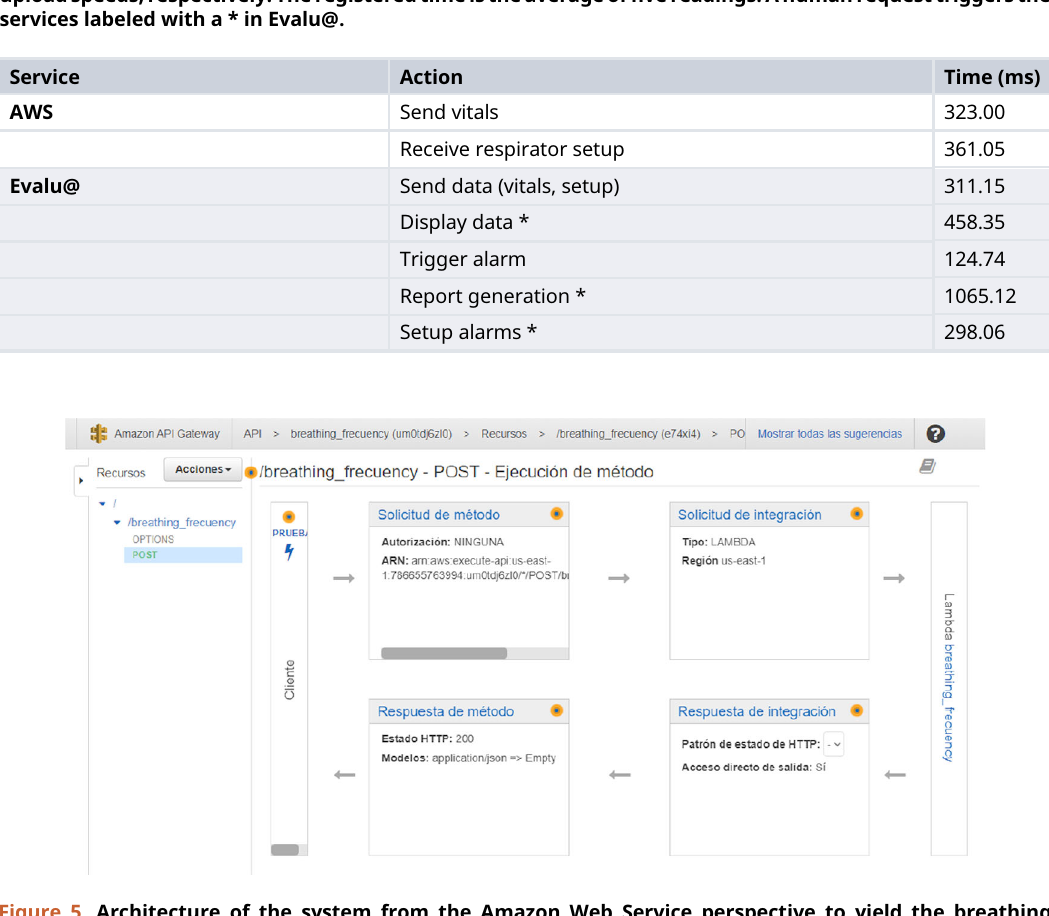
Figure 5. Architecture of the system from the Amazon Web Service perspective to yield the breathing